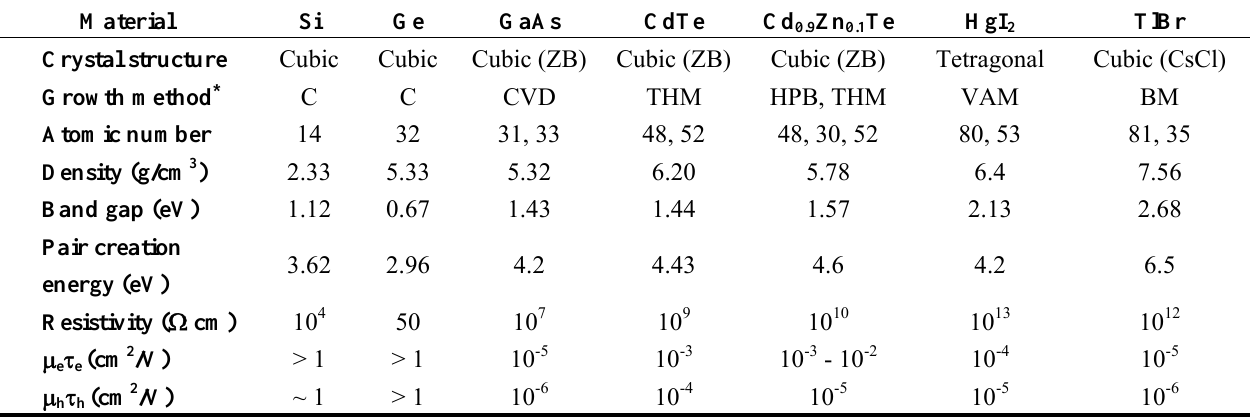
Table 1. Physical properties of the principal compound semiconductors at T = 25